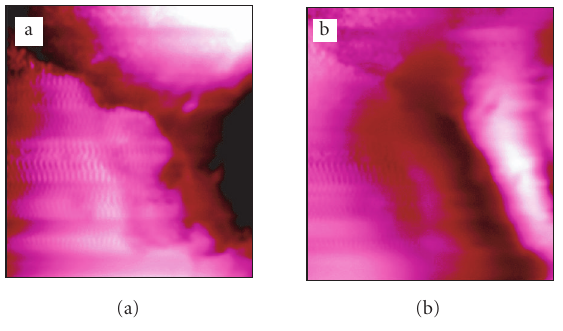
Figure 38: Shear-force AFM (a) (10 μ m, Z range 200nm) and aper- tureless SNOM (b) of a dried Ag sol on a microscope